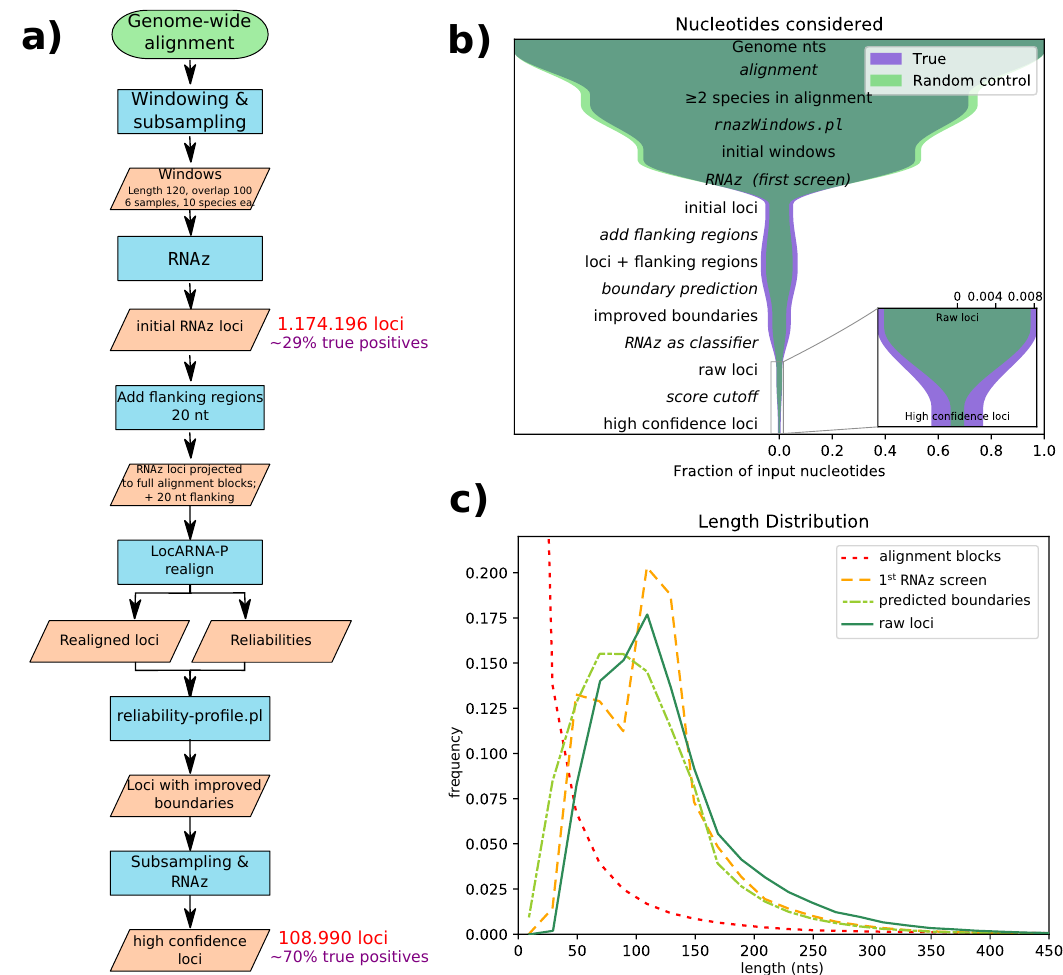
Figure 1. ( a ) A flowchart for our computational pipeline. ( b ) Number of nucleotides considered at every step of the pipeline as a fraction of the number of nucleotides in the genome. The inner (green) funnel is the random control used to estimate the false discovery rate. ( c) The length distribution of the alignment blocks (red) and our hits at different points of the